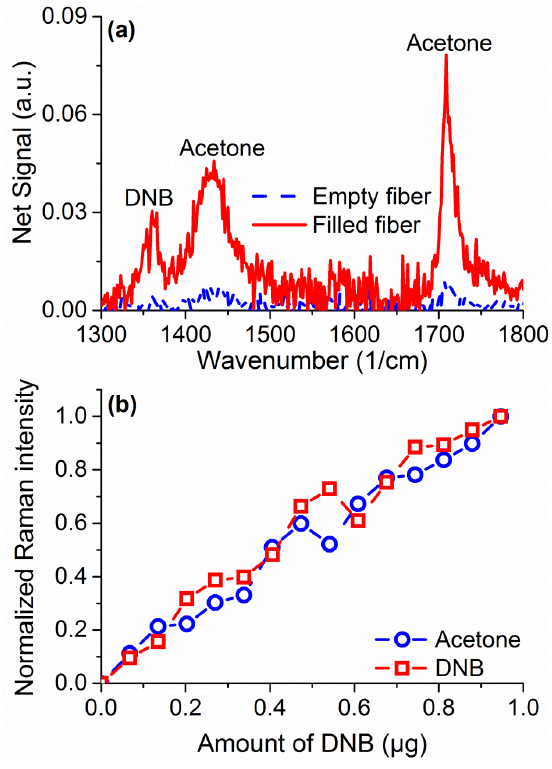
Figure 9. ( a ) Comparison of Raman spectra collected from an empty fiber (dashed line) and a fiber filled with a 2% w.t. 1,4-dinitrobenzene (DNB) acetone solution after subtraction of the silica background signal using a suspended core fiber; ( b ) Integrated intensity for DNB (squares) and acetone (circles) Raman spectra as a function of the amount of DNB inside a suspended core